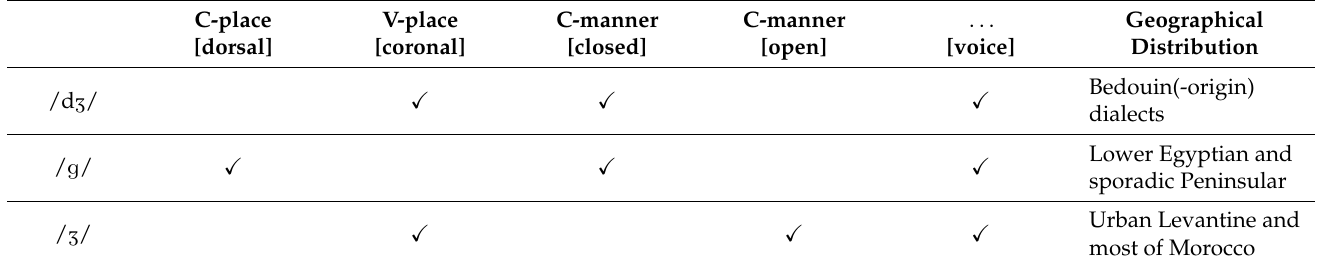
Table 2. Representational typology of * ˇg phoneme